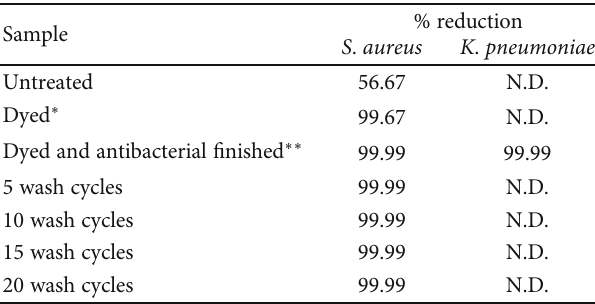
Table 4: Antibacterial activity against S . aureus and K .